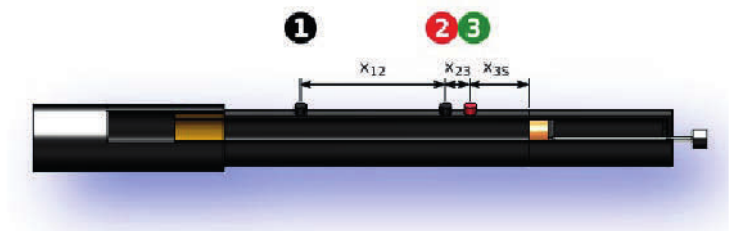
Fig. 4. Principle scheme of impedance tube set for experimental